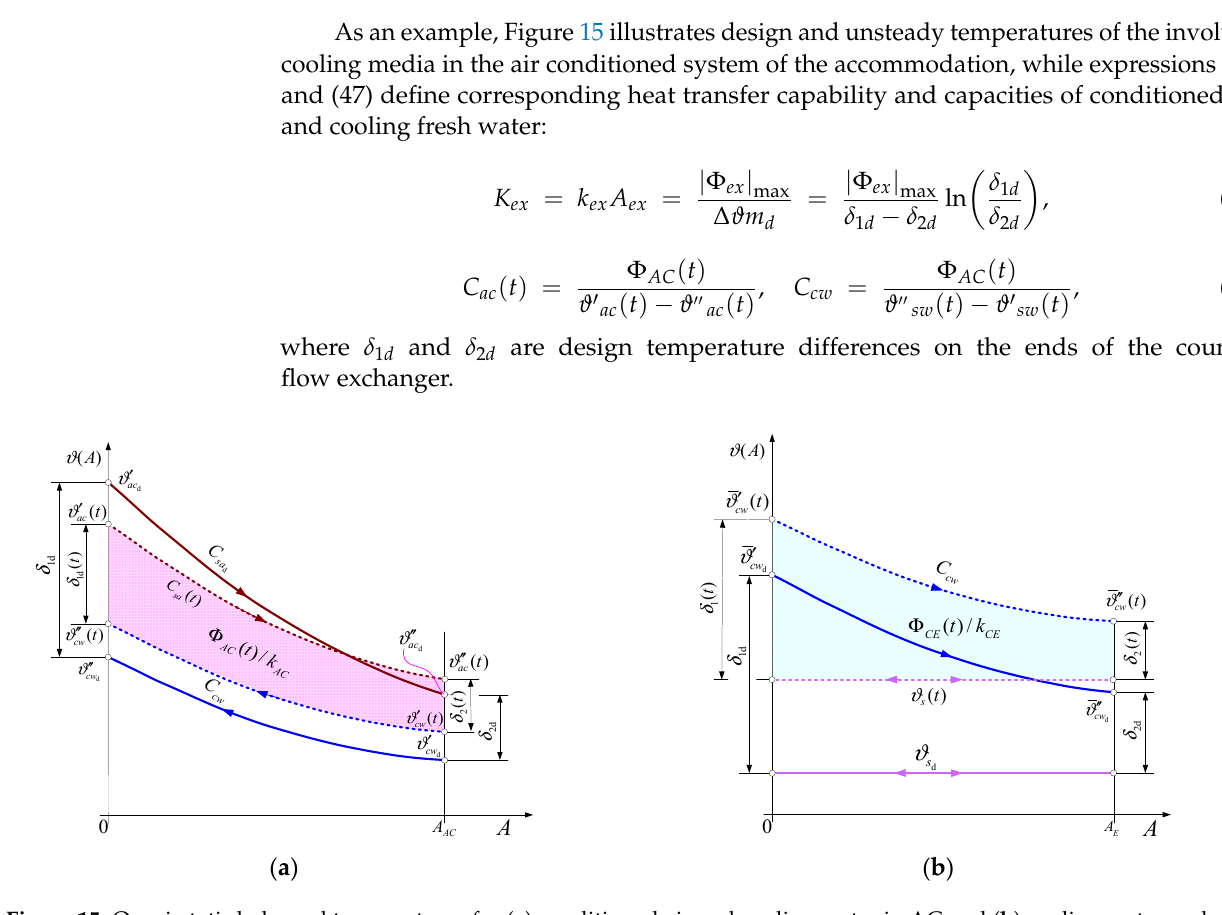
Figure 15. Quasi-static balanced temperatures for ( a ) conditioned air and cooling water in AC and ( b ) cooling water and cooling steam in evaporator of LBARU-a.